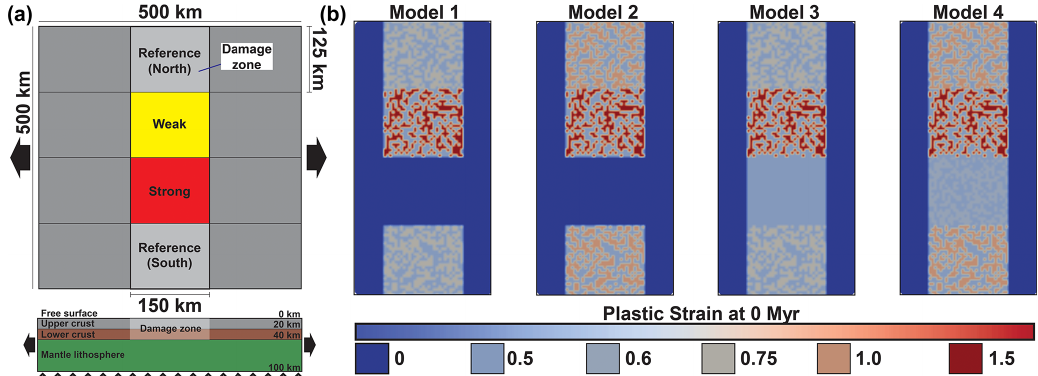
Figure 2. (a) Diagram showing the map view and cross-sectional setups for the model. Strain is applied across a 500km wide and 100km deep area, with a 150km wide “damage zone” extending to 40km depth across the centre of the model where IPS is assigned to unit blocks. (b) Images of the IPS distribution applied to each model prior to extension at 0Myr. Variations in IPS values between 5km 3 unit blocks define various strength